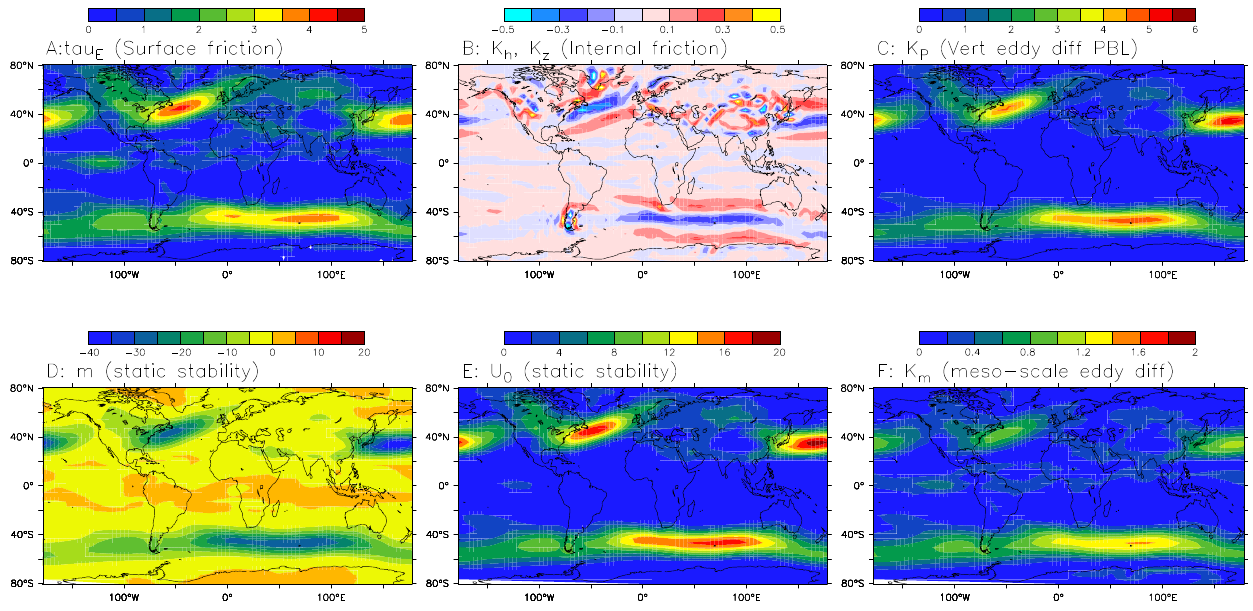
˜ K PBL , (d) m , min , (b) K H and K 2 ,z , (c)